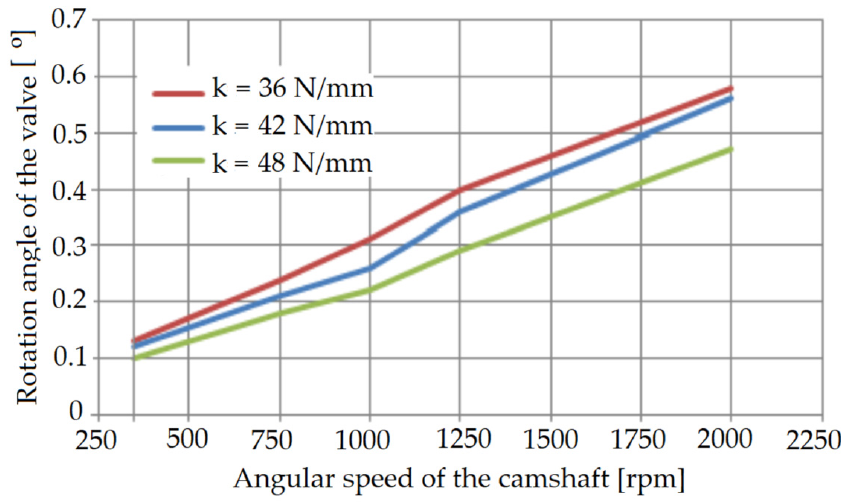
Figure 21. Influence of the spring stiffness coefficient on the angle of rotation of the valve.